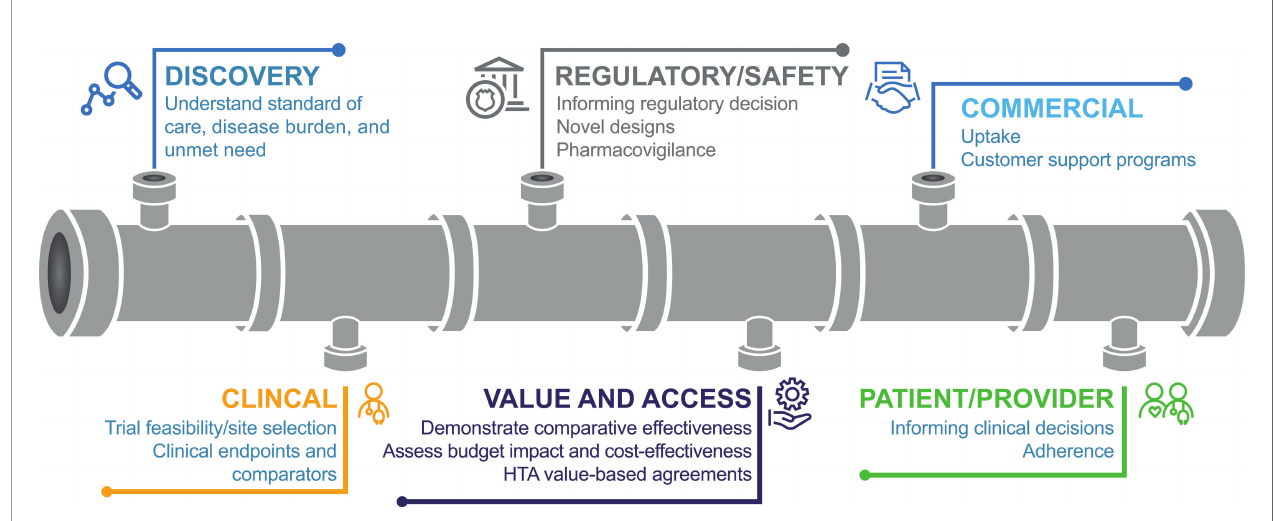
FIGURE 2 | Uses for RWD throughout the drug development cycle (18). HTA, health technology